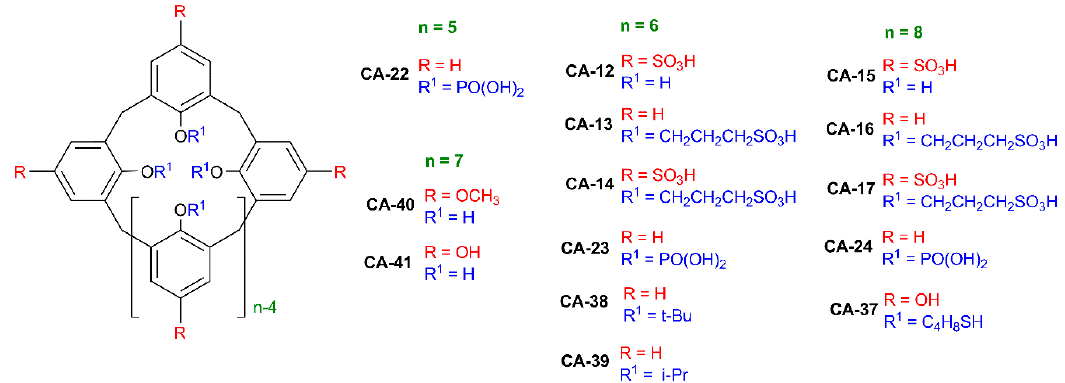
Figure 4. Structures of calix[n]arenes (n = 5–8.